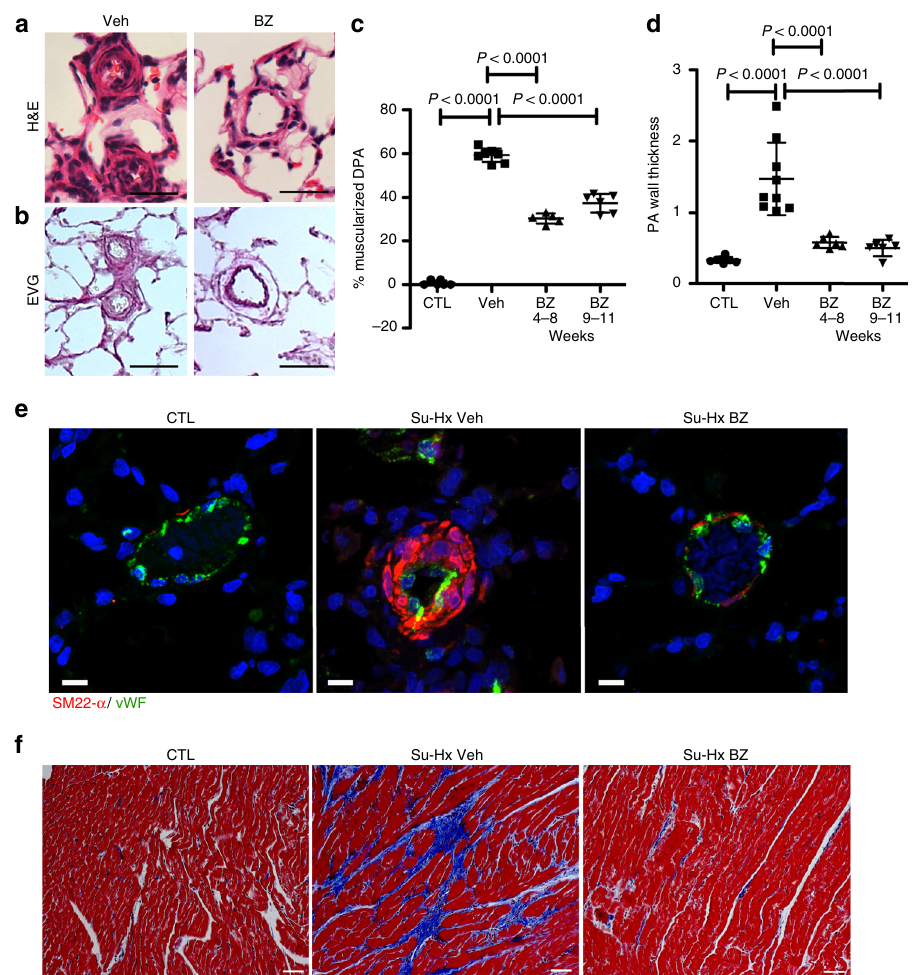
Fig. 4 Benzarone treatment reduces muscularization of distal pulmonary arteries (DPA) in the Sugen-hypoxia (Su-Hx) protocol. a Representative histology of DPAs from vehicle-treated (Veh) and BZ-treated rat lungs subject to the Su-Hx protocol. Hematoxylin and eosin (H&E) stained sections are shown. Scale bar = 100 μ m. b Representative histology of DPAs from vehicle-treated (Veh) and BZ-treated rat lungs subject to the Su-Hx protocol. Elastica van Gieson (EVG) stained sections are shown. Scale bar = 100 μ m. c Percentage muscularized DPAs (diameter of 100 μ m or below) in H&E stained rat lung sections are plotted. Each data point represents three sections per animal. CTL rats maintained in room air n = 6, VEH vehicle-treated animals subject to the Su-Hx protocol n = 8, BZ prevention – prevention protocol n = 5, BZ-treatment protocol n = 6. Data plotted as the mean ± SD, signi fi cance assessed by pairwise t -tests. d Pulmonary artery (PA) wall thickness in rat lung sections: difference in diameters de fi ned by the lamina elastic externa and the lumen in two perpendicular directions of transversally cut vessels below 200 μ m in diameter. Each data point represents an average of at least two sections per animal. CTL rats maintained in room air n = 8, VEH vehicle-treated animals subject to the Su-Hx protocol n = 9, BZ-prevention protocol n = 6, BZ treatment protocol n = 6. Data plotted as the mean ± SD, signi fi cance assessed by pairwise t -tests. e Representative sections from CTL (room air), Su-Hx rat lungs treated with vehicle (Su-Hx Veh), and Su-Hx lungs treated with BZ (treatment protocol; Su-Hx BZ) were stained for the smooth muscle cell marker SM22- α (red), the endothelial cell marker von Willebrand factor (vWF; green), and the nuclear marker DAPI (blue). Scale bar = 10 μ m. f Representative images of Masson ’ s Trichrome stained heart sections show fi brosis (blue) in the RV of Su-Hx – Veh rats that is signi fi cantly reduced upon BZ treatment. Scale bar = 100 μ m. Source Data are provided as a Source Data fi